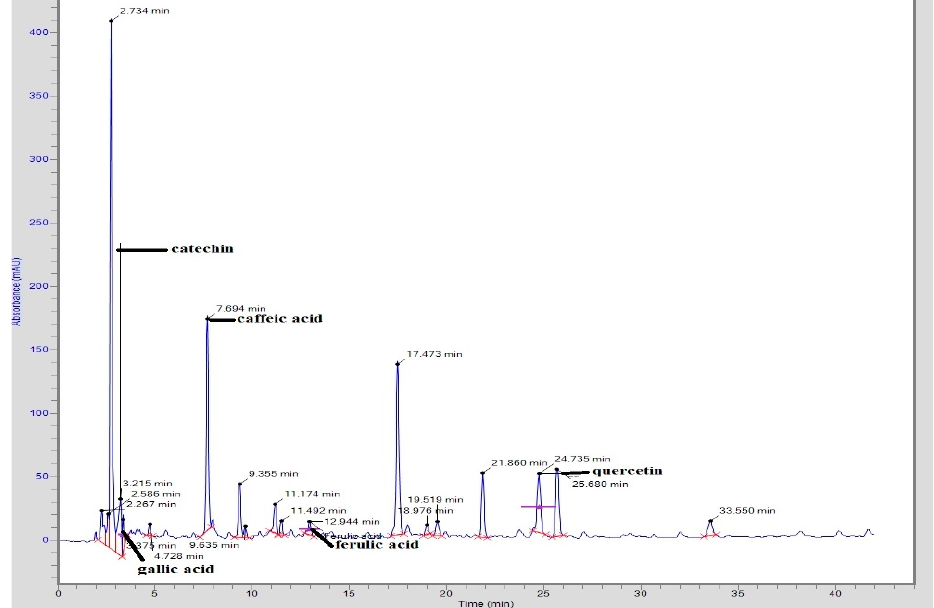
Figure 1. HPLC chromatogram of Caralluma tuberculata methanolic extract.